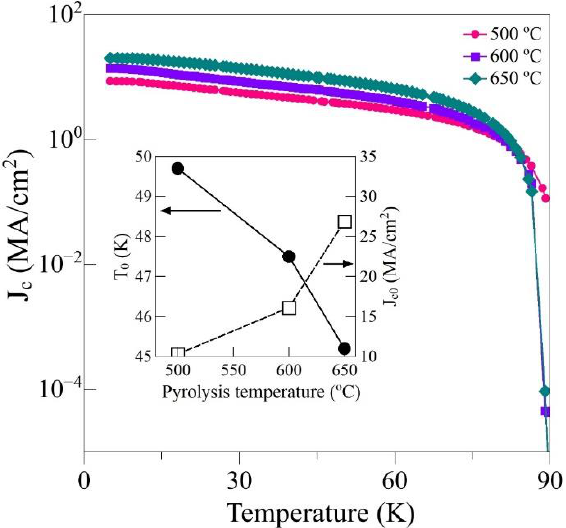
Figure 5. Temperature dependence of the critical current density J c ( T ) of the YBCO thin films treated at different pyrolysis temperatures; (inset) Variation of the fitting parameters J c0 and T 0 as a function of pyrolysis temperature (see text).